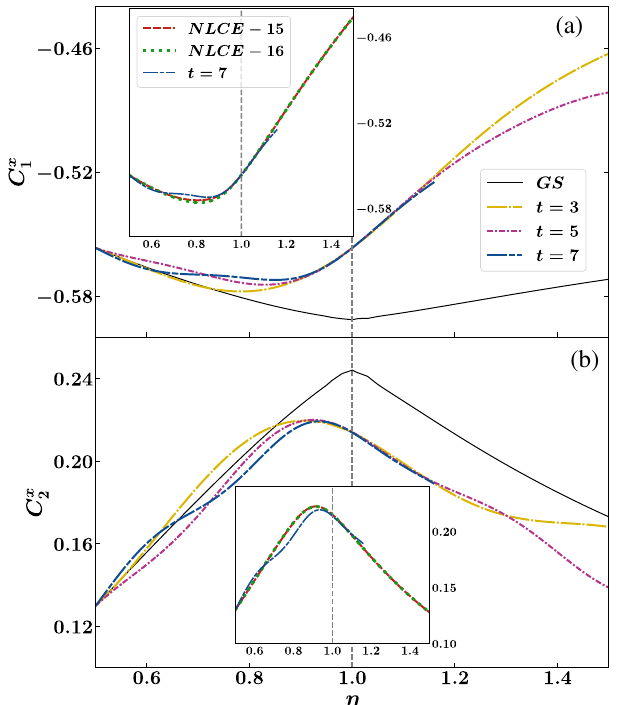
FIG. 13. Behavior of local operators (a) C x 1 and (b) C x 2 about the topological transition at η c ¼ 1 in the bond-alternating Heisen- berg chain. The main figures display results of the short-time dynamics (obtained using iTEBD) following quantum quenches (see the text for details about the quenches) as well as in the ground state (obtained using iTEBD). The insets show the expected long-time thermal equilibrium results after the quenches evaluated using NLCE to 15 orders (NLCE-15) and 16 orders (NLCE-16), as well as the longest-time result reported in the main figure. All the results exhibit extrema close to the critical